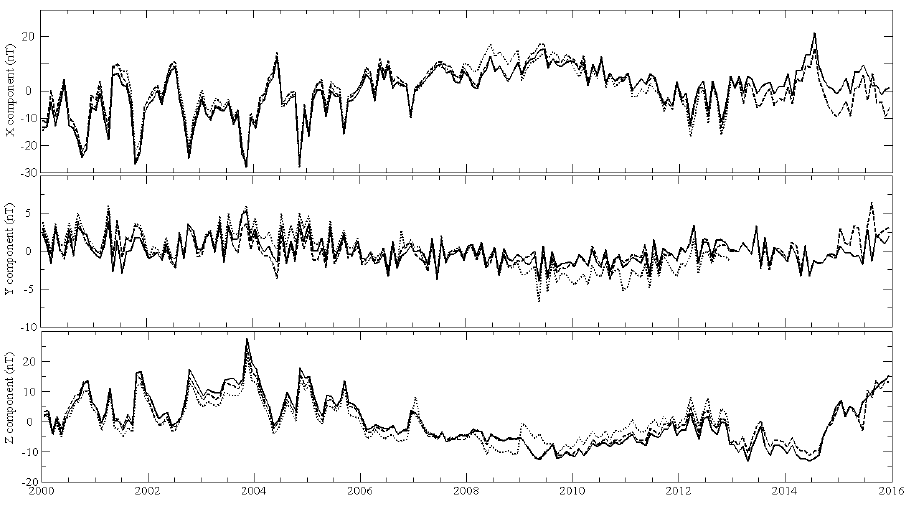
Figure 13. The external contribution (by POMME-9 model) to: a) NGK observatory (solid line), b) FUR observatory (dashed line), c) WIK observatory (dotted line).